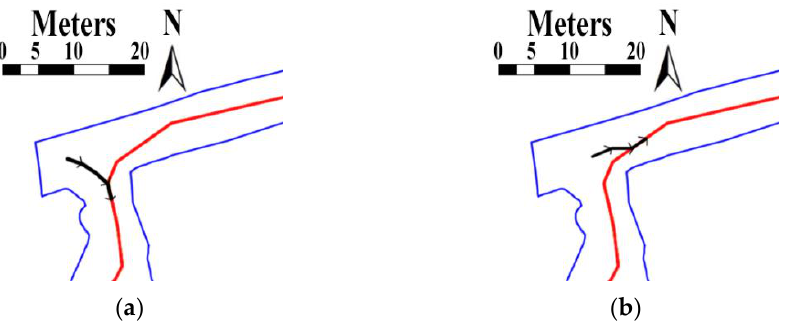
Figure 16. The simulation result for the kidnapping problem. ( a ) With turnable kidnapping; ( b ) with unturnable kidnapping.